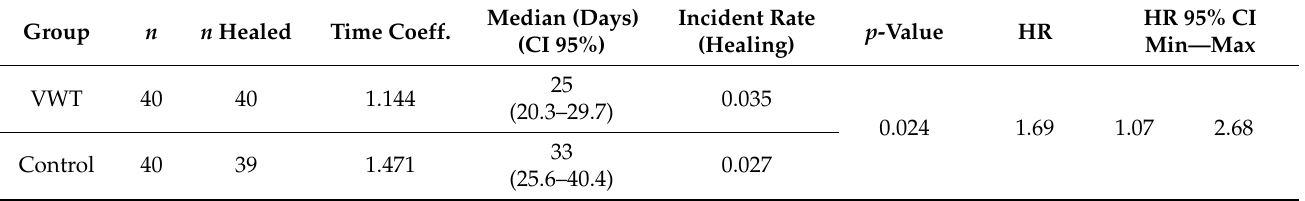
Table 2. Diabetic wound healing